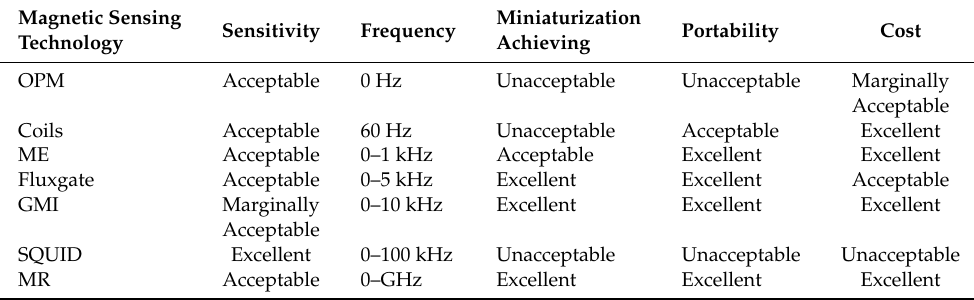
Table 2. Magnetic sensing technologies comparison in biomedical